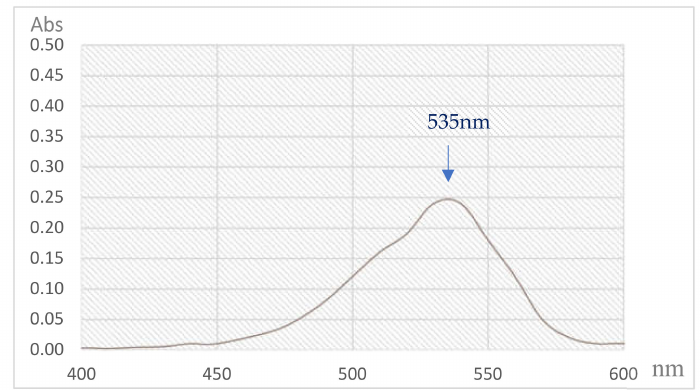
Figure 7. The spectrum of UV absorption of purified PG produced by S. marcescens TNU01 under optimal